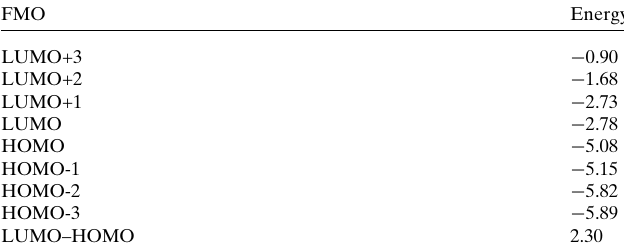
Table 3 Calculated frontiermolecular orbital energies